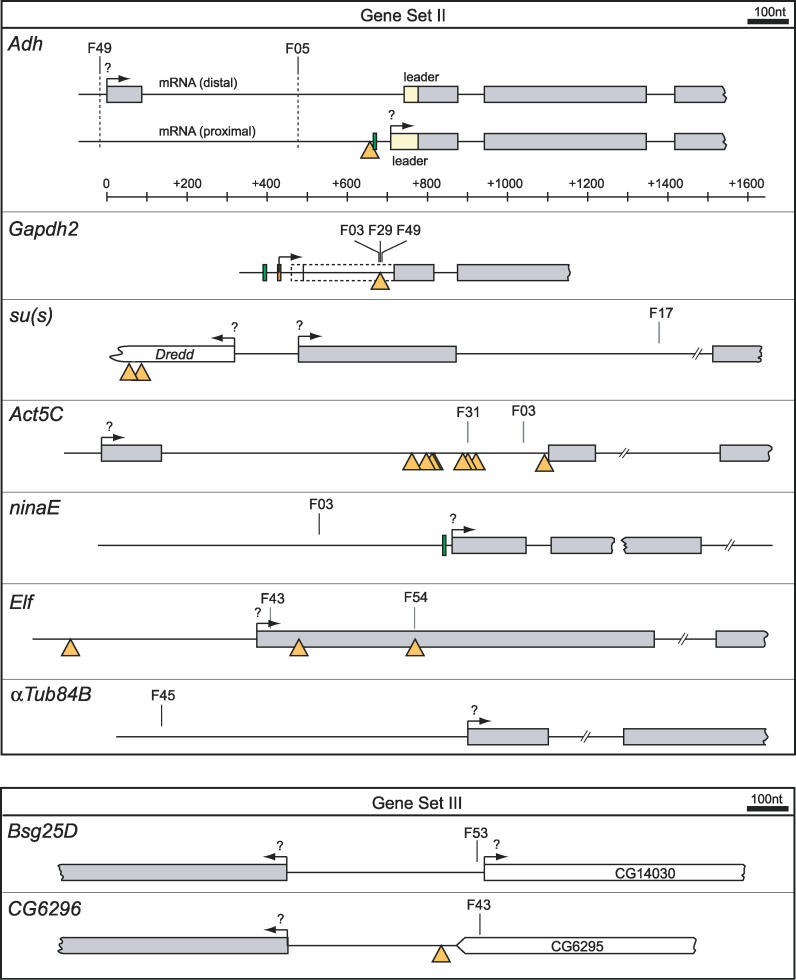
Locations of P Elements Integrating into the Proximal Promoters of Non–Heat-Shock Genes Resembling Heat-Shock Genes in Relevant Features of Their Proximal Promoters (Gene Set II), and in Genes Dissimilar to Heat-Shock Genes (Gene Set III)Data are plotted as in Figure 2 except as follows: Primer sets used in the screens amplified regions 3′ to transcription start site of different length; P elements discovered upstream of the initiator are plotted (pale), but not included in comparative analyses (i.e., in su(s) in population F17, in Act5C in F03 and F31, and in Elf in F43 and F54). Note that in Gene Set III, the two P elements discovered are not clearly associated with their focal genes, integrating into or just upstream of genes neighboring the focal genes. For population codes, see Figure 1. Table 1 provides additional information about the gene sets.